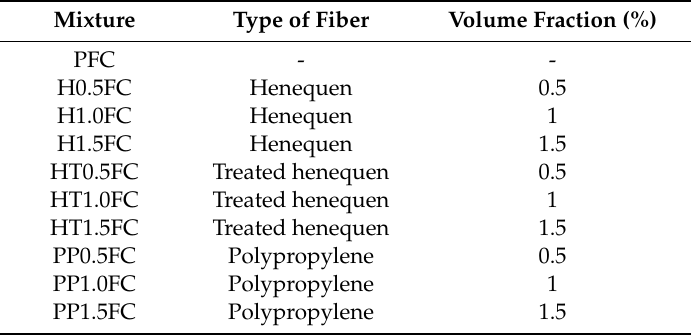
Table 3. Foamed concrete mixtures for the mechanical